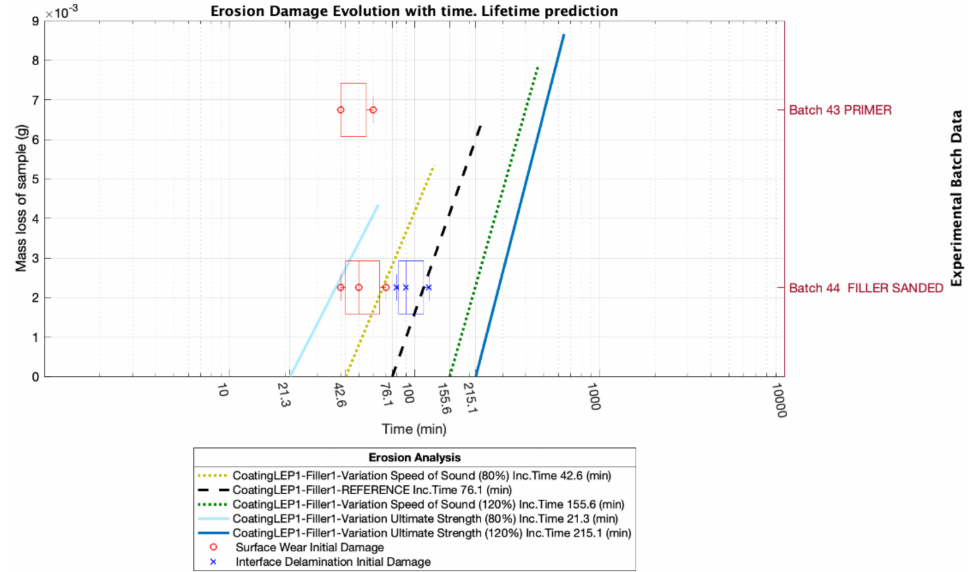
Figure 8. Lifetime analysis for experimental tested and simulated material LEP prototype comparing 20% variation of LEP Speed of Sound and Ultimate